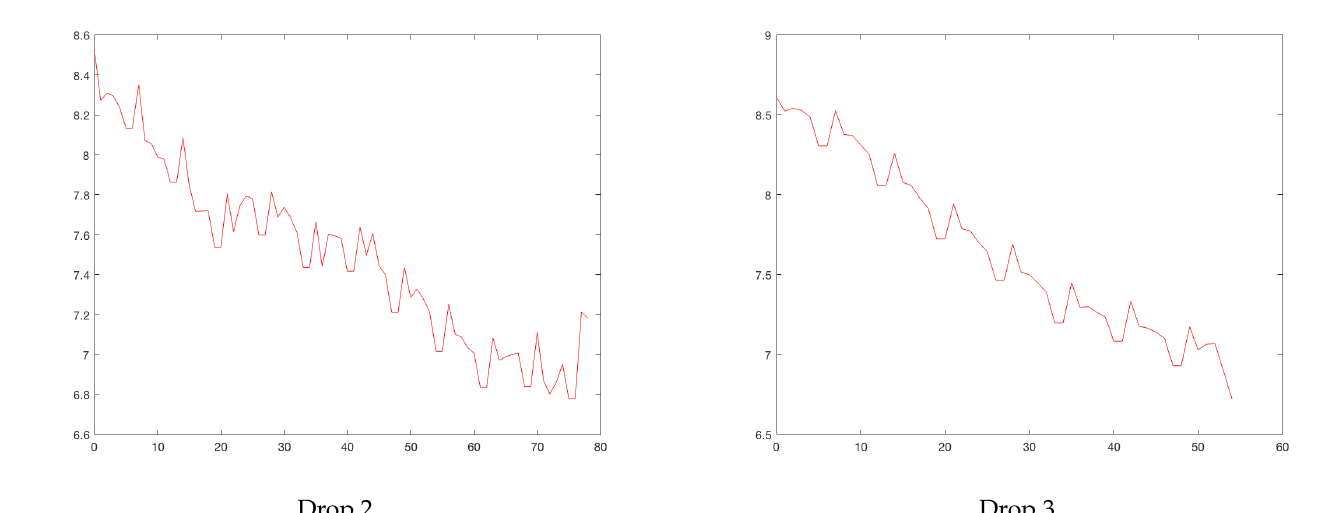
Figure A14. Madrid’s drops. Horizontal axis, days; vertical axis: logarithm of daily cases.